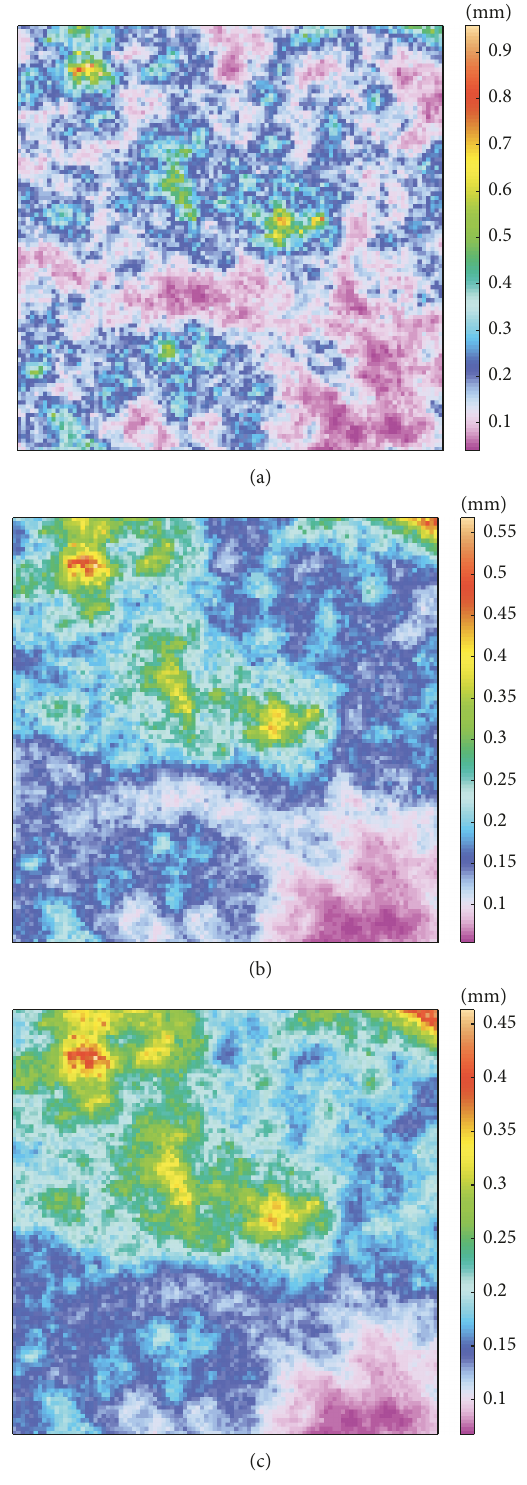
Figure 16: Aperture fields with different correlation lengths: (a) 𝜆 = 0.08 dm; (b) 𝜆 = 0.36 dm; (c) 𝜆 = 0.64